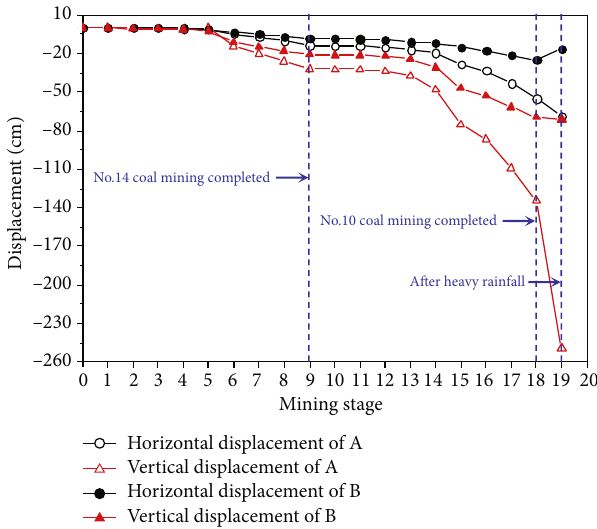
Figure 9: Displacement of monitoring points A and